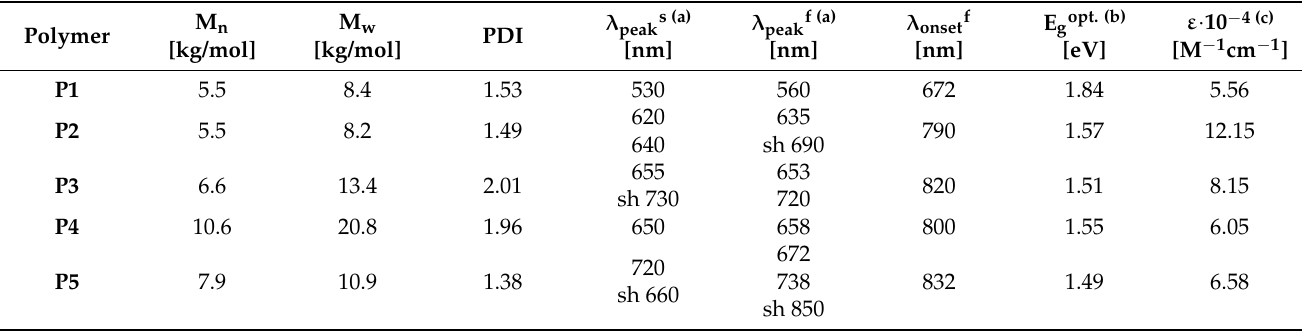
Figure 1. Absorption spectra of the polymers P1 – P5 : ( a ) in chloroform solutions, ( b ) in solid-state films. Table 1. Molecular masses, maxima of absorption peaks, molar absorption coefficients, and optical band gaps, E gopt , of P1 – P5 .